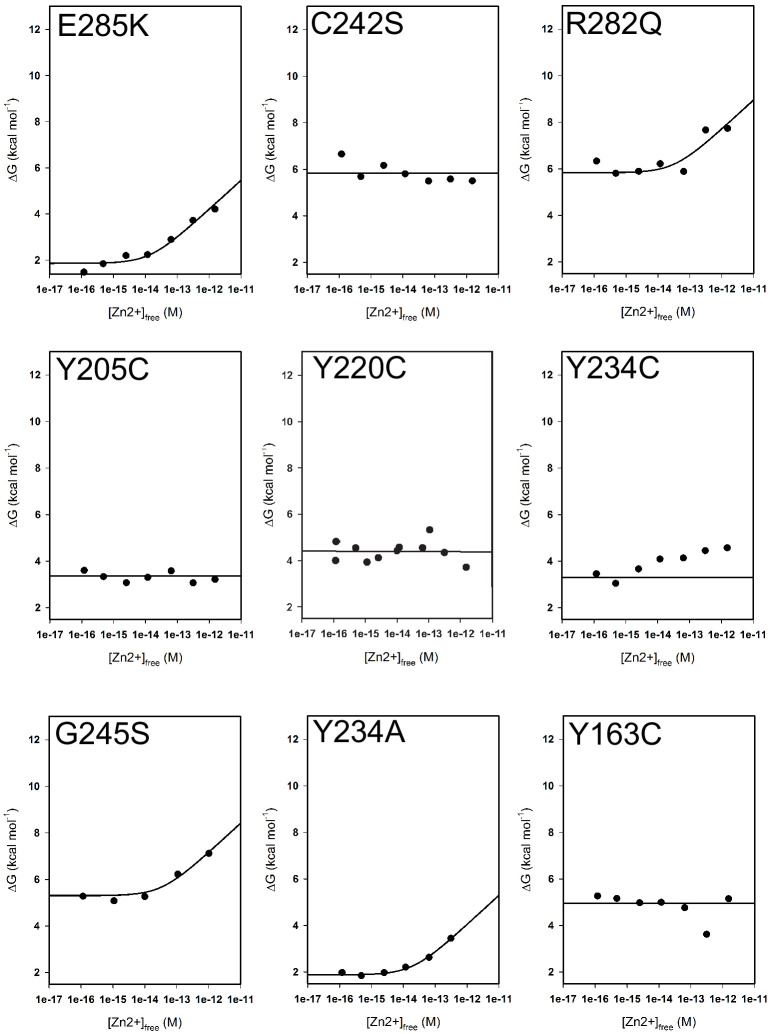
Free energy of folding versus buffered [Zn2+]free for p53 DBD mutants.See legend to Figure 3—figure supplement 1 for details. No data points were rejected in any of the plots.